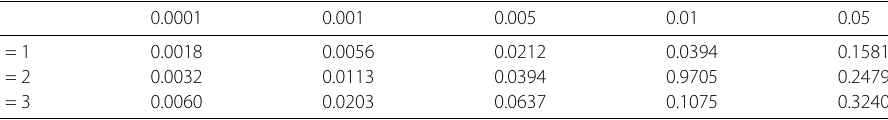
Table 2 k = 1.2, the relative root mean square errors (cid:10) ( u ) for various noise levels ε 0.0001 0.001 0.005 0.01 0.05 p = 1 0.0018 0.0056 0.0212 0.0394 0.1581 p = 2 0.0032 0.0113 0.0060 0.0203 0.0637